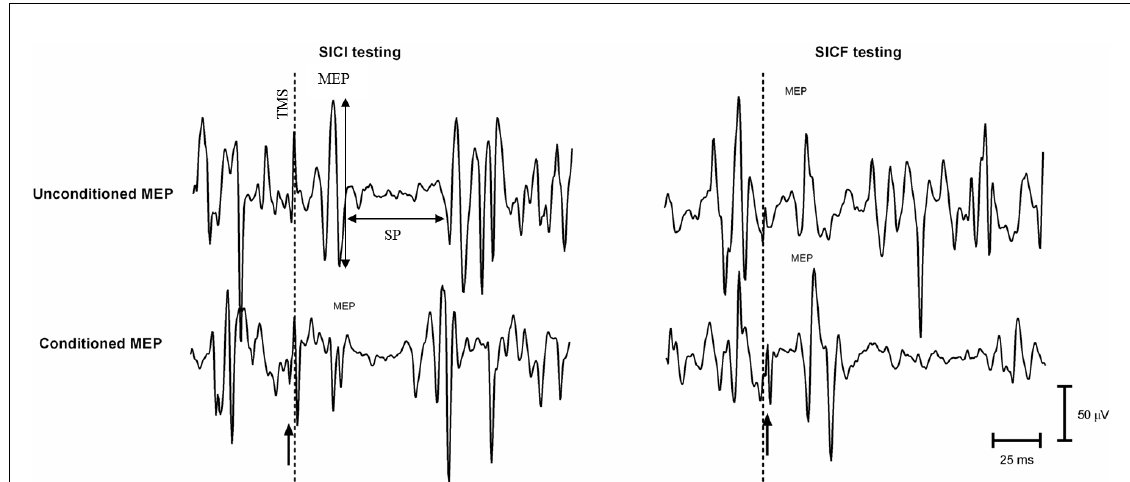
Figure 1. TMS: transcranial magnetic stimulation; SICI: short-interval intracortical inhibition; SICF: short-interval intracortical facilitation; MEP: motor evoked potentials; SP: silent period; small arrow (lower panel): conditioned pulse; dotted line: test pulse.